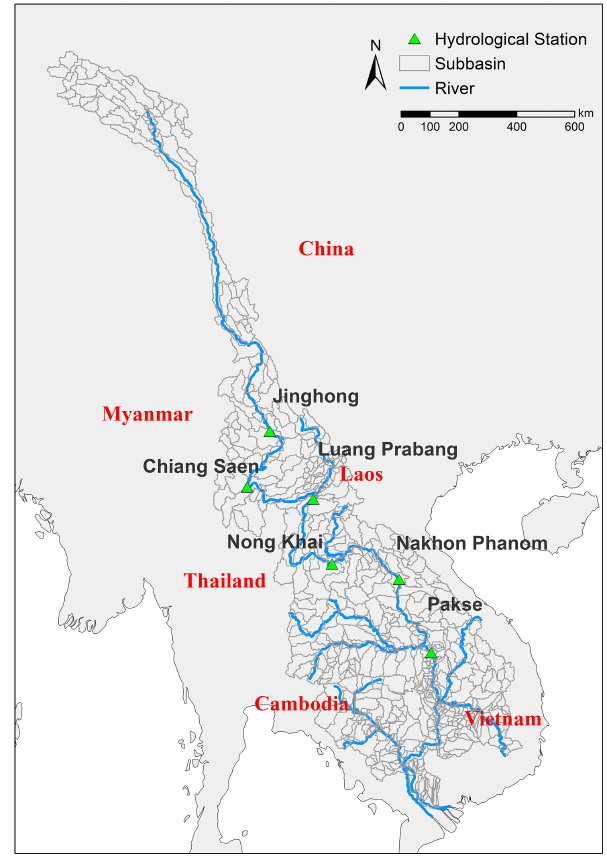
Figure 1. Map of the Lancang–Mekong River basin, subbasin divi- sion and hydrological